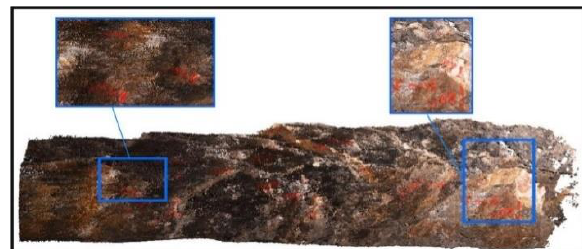
Figure 11. An example of double-line 3D reconstruction based on deep learning (side